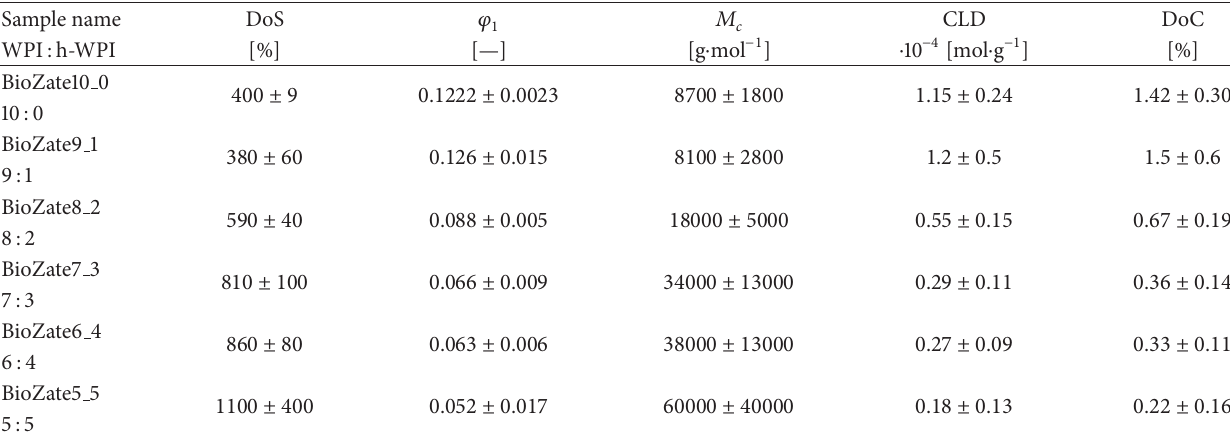
Table 3: Volume fraction of polymer in swollen gel 𝜑 1 , number average molecular weight of the polymer between cross-links 𝑀 𝑐 , cross-link density, and degree of cross-linking with 95% confidence intervals of different h-WPI ratios in WPI-based